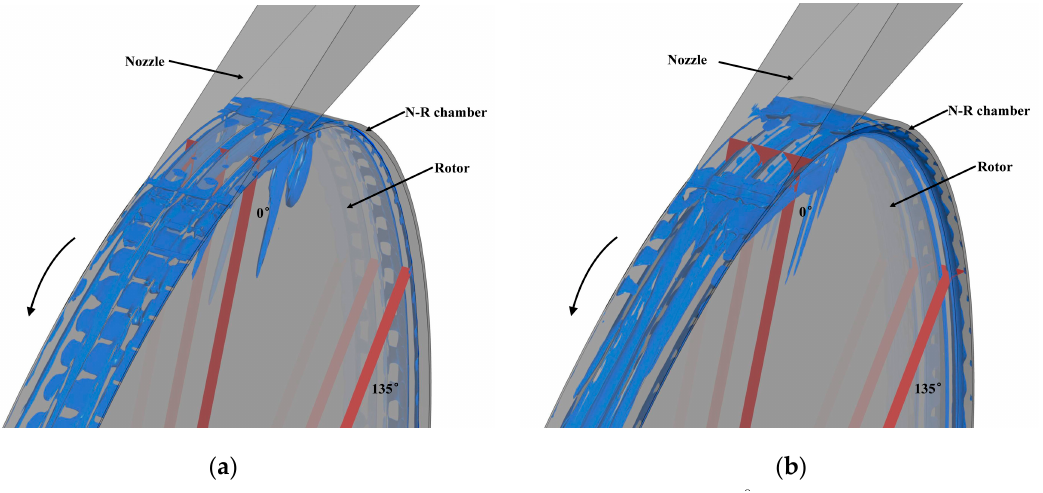
( a ) ( b ) Figure 15. Iso-surface of Q distributions for two turbine models, 8 4 10 Q = × . ( a ) OTM-B; ( b ) OTM-T-2. Figure 15. Iso-surface of Q distributions for two turbine models, Q = 4 × 10 8 . ( a ) OTM-B; ( b )